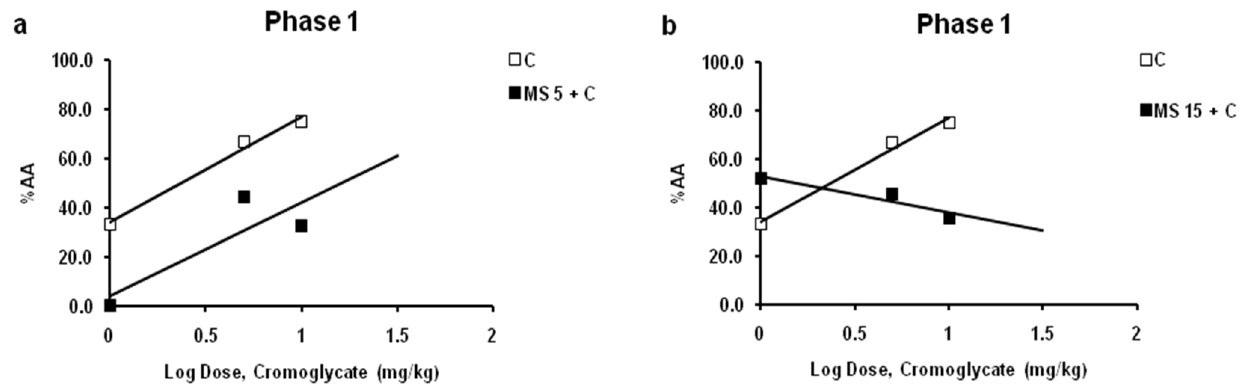
Figure 4. Interaction between cromoglycate (CG) and magnesium sulfate (MS) in phase 1 of formalin test. Log dose–response for CG (1, 5, 10 and 30 mg/kg; s.c.) alone and in the combination with MS (5 mg/kg) ( a ) or MS (15 mg/kg) ( b ) in phase 1. Data are expressed as a percent of antinociception (AA (%)).